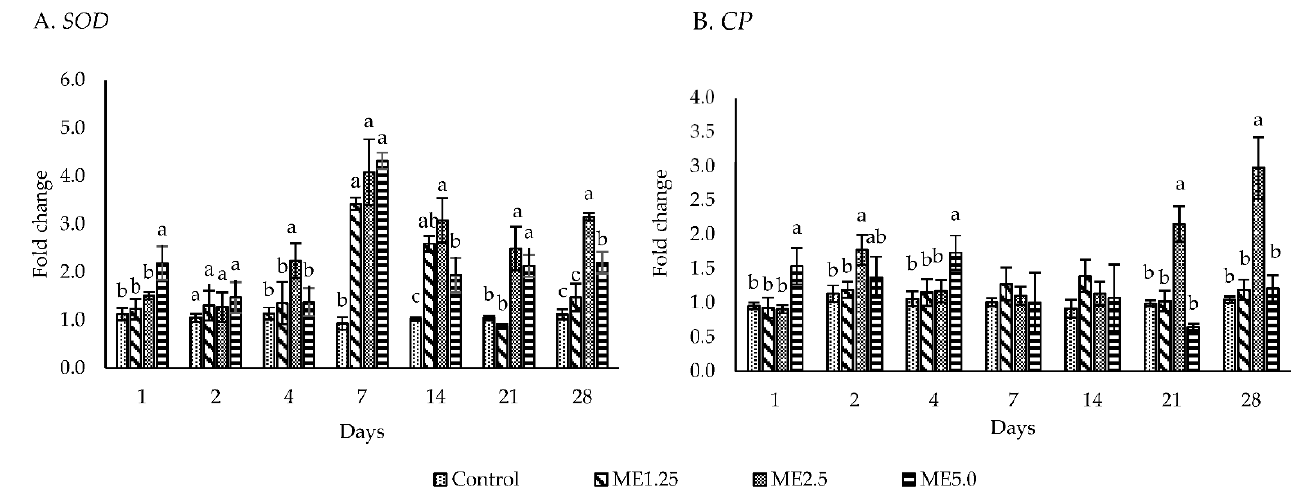
Figure 5. The effect of different concentrations of moringa extract in diet (control, ME1.25, ME2.5, and ME5.0) on the expression of SOD and CP in the hemocytes of whiteleg shrimp. The data are expressed as the mean ± standard deviation ( n = 3). Bars with different letters at the same time point are significantly different ( p < 0.05).